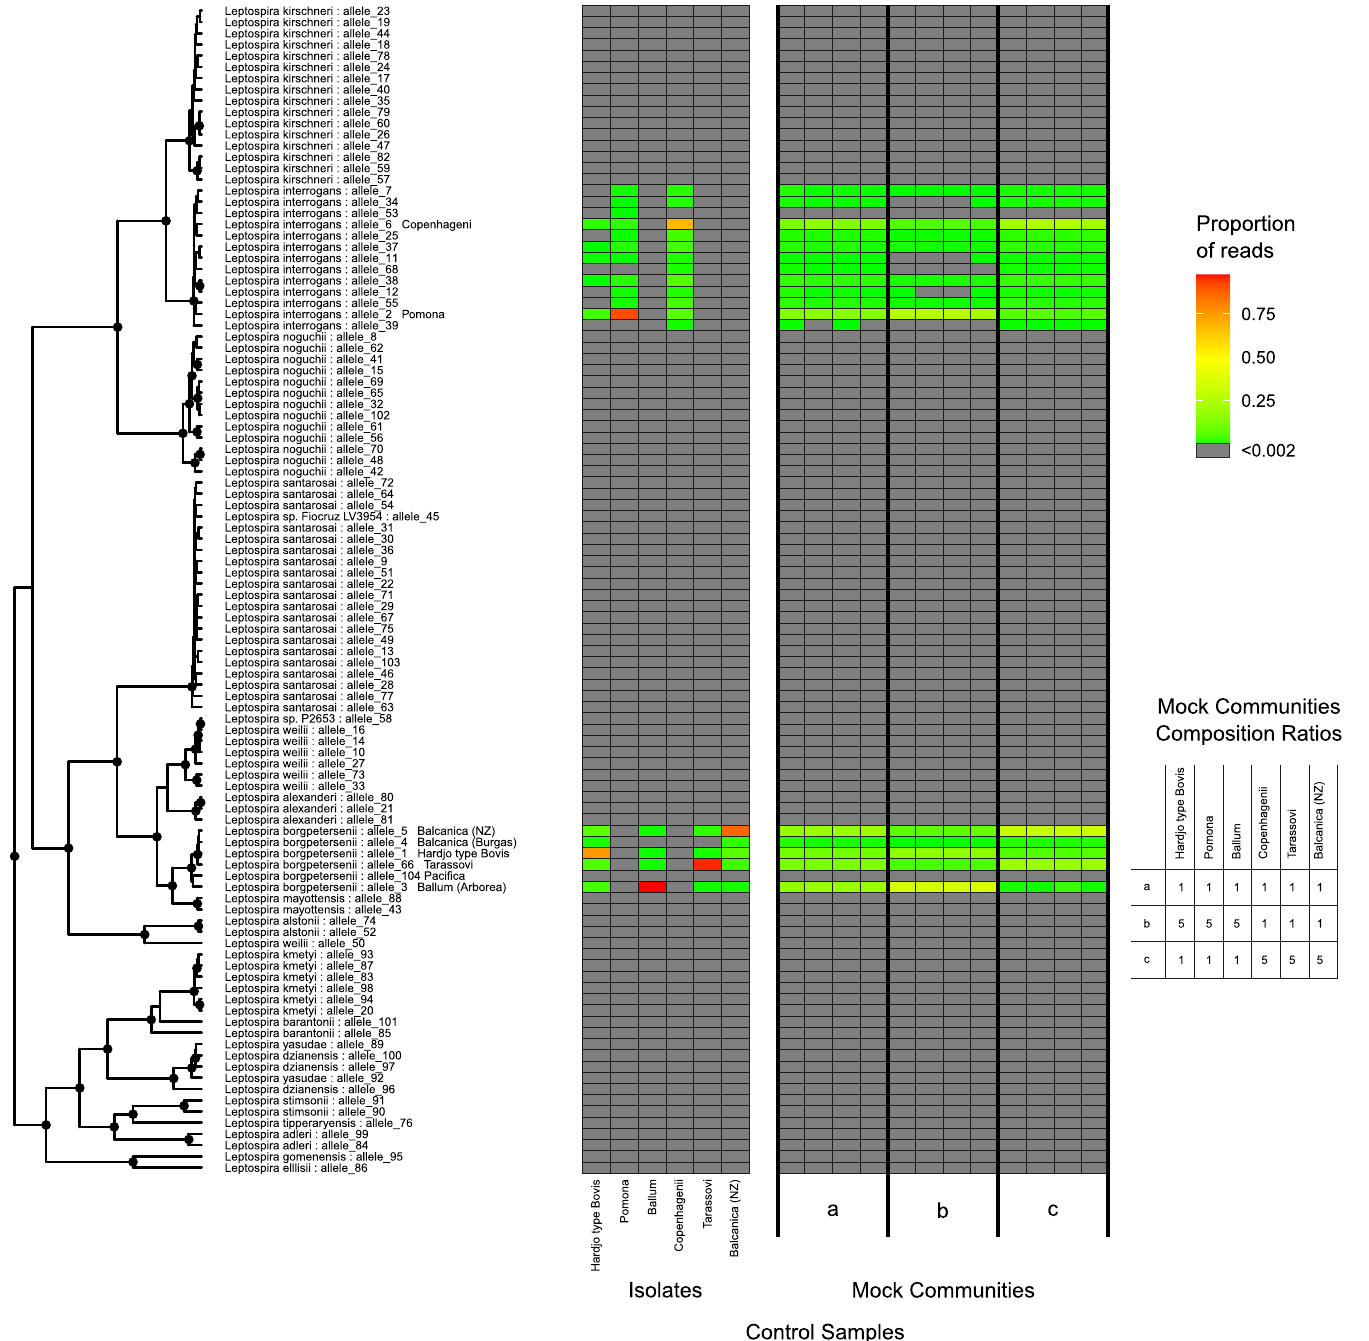
Fig 3. Leptospira variant identification using metabarcoded primers amplifying the glmU locus from individual serovar reference-strains (isolates) and mock communities (a, b, and c) using Oxford Nanopore sequencing. The ratio of DNA in each mock community is presented in the table (bottom right). Results are displayed relative to the phylogenetic position for each allele in the glmU -derived phylogenetic tree from Fig